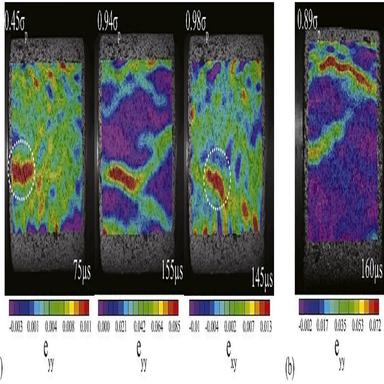
Strain fields of rock at different instants at a strain rate of (a) 93 s − 1 and (b) 70 s − 6 . The copyright permission for this figure has been granted.